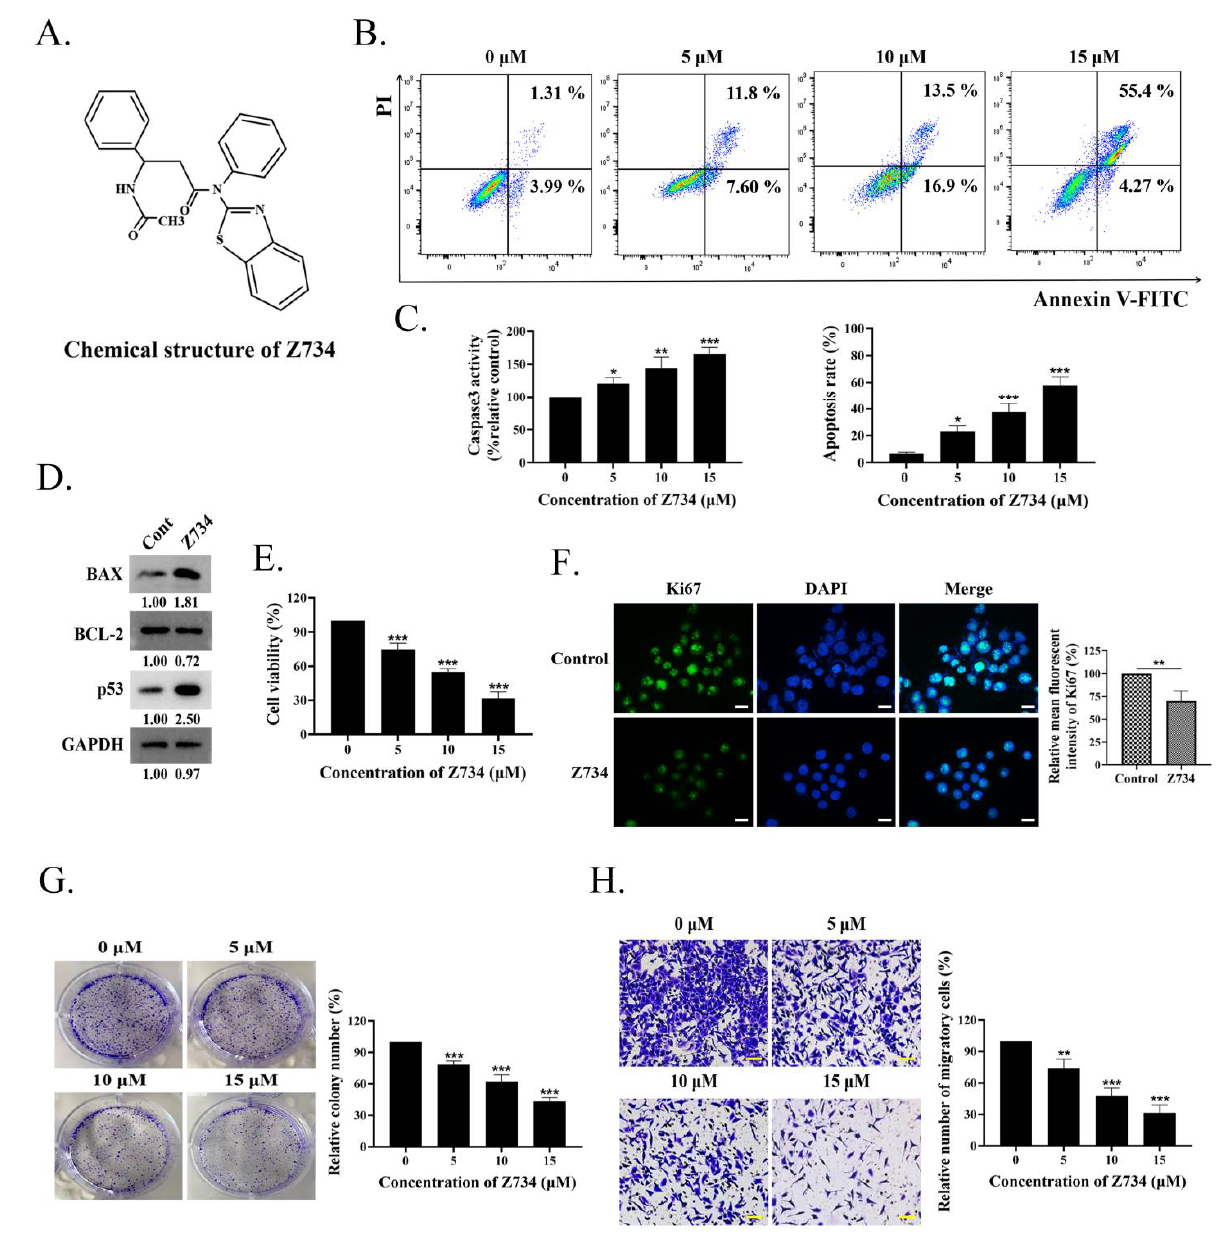
Figure 1. Z734 causes apoptosis and inhibits MCF–7 cells proliferation and migration. ( A ) The chemical structure of Z734. ( B ) Apoptosis levels were detected via flow cytometry. WT MCF–7 cells were treated with Z734 (0, 5, 10, and 15 µ M) for 12 h. Flow cytometric analysis of apoptotic cells was conducted using AnnexinV–FITC. ( C ) Measurement of Caspase3 activity after Z734 intervention in MCF–7 cells. ( D ) Apoptosis–related protein levels after treatment with Z734 were determined via Western blot analysis. ( E ) MCF–7 cells were treated with different doses of Z734 and incubated for 12 h. Cell proliferation was assessed via CCK–8 assays. ( F ) Ki67 distribution after treatment with Z734 was determined via immunofluorescence. Quantification of fluorescence was performed on the average optical density using the ImageJ software. Scale bars = 10 µ m. ( G ) The percentage of colonies of MCF–7 cell lines was determined after treatment with Z734. ( H ) MCF–7 cells were treated with Z734 for 12 h and then analyzed for migration by transwell analysis. Scale bars = 20 µ m. Data shown in ( B , C , E , G , H ) were used one–way ANOVA with Tukey’s post hoc test. Data shown in ( F ) was used two–tailed Student’s t –test. All assays were performed in triplicate, and the data are expressed as mean ± standard deviation. * p < 0.05, ** p < 0.01, *** p < 0.001, n.s., no significant